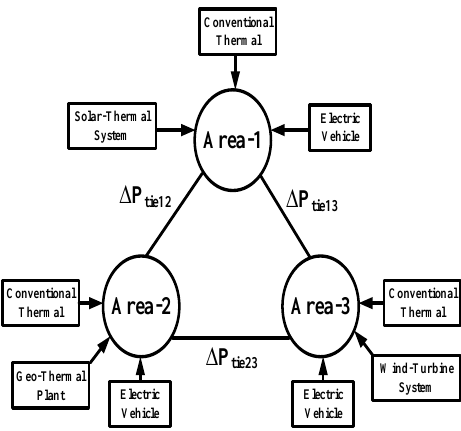
Figure 2. Interlinked three-area power